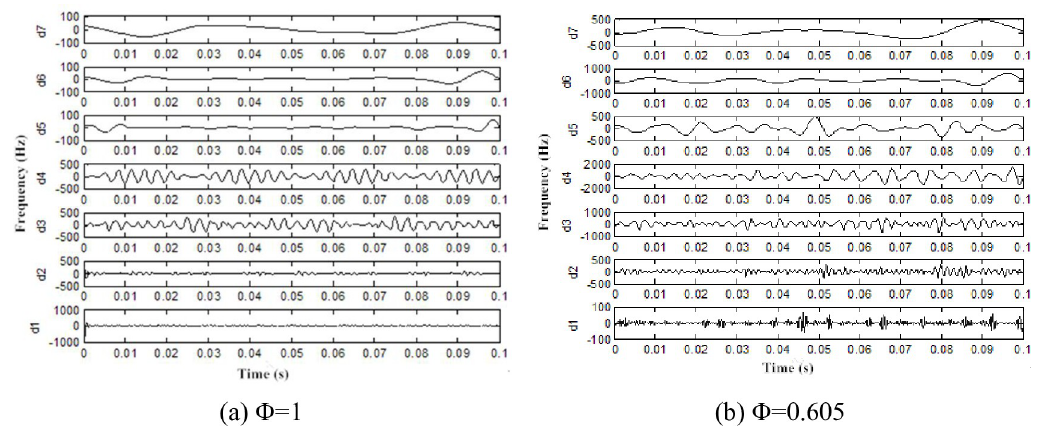
Fig 9. Restructuring signal of interstage pressure pulsation.